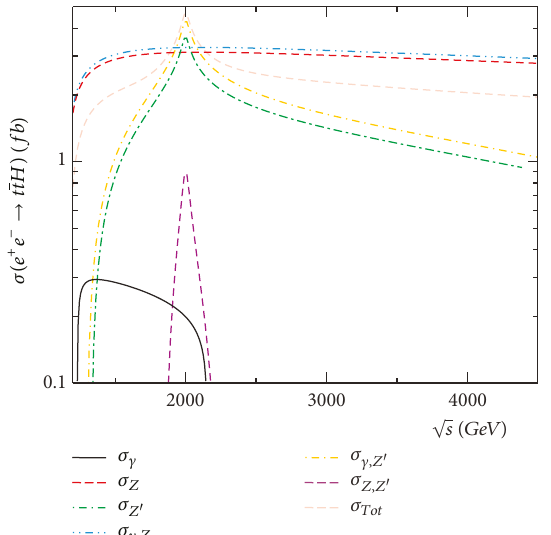
Figure 7: Same as in Figure 3, but for 𝑒 + 𝑒 − 󳨀→ 𝑡𝑡𝐻 .